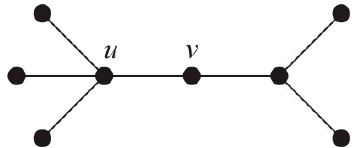
Figure 10. The vertices u and v are not H -equivalent but D ( u ) = D ( v ).